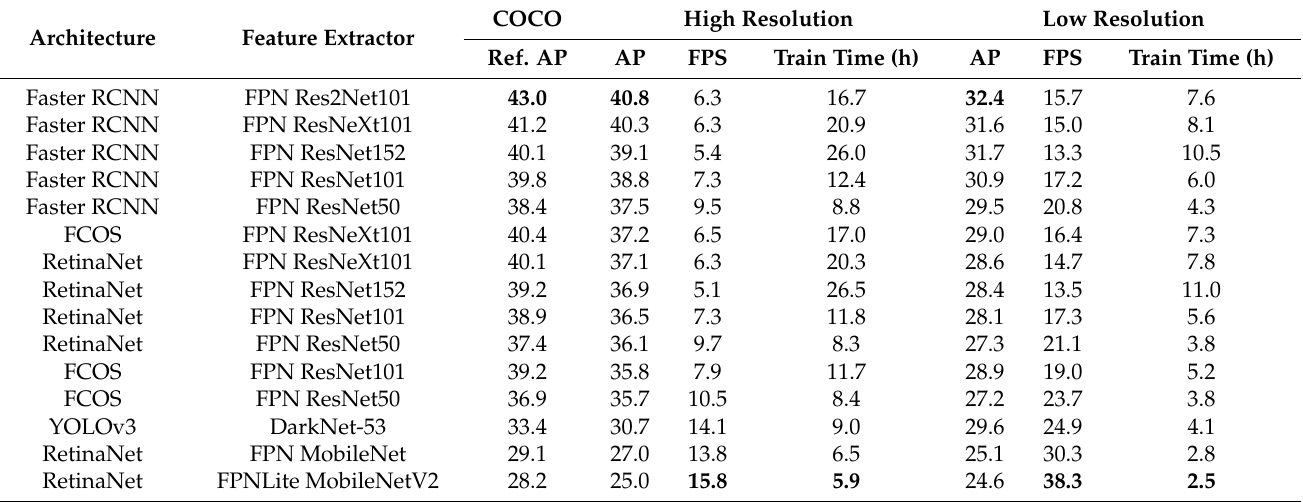
Table 7. Ranking of the models used ordered by the AP value obtained over the Waymo dataset with the high-resolution version. The COCO Ref. AP refers to the reference value obtained by each model in the COCO 2017 validation set, extracted from the MMDetection repository. The inference FPS and total training time in hours are also provided. The best results are highlighted in bold.